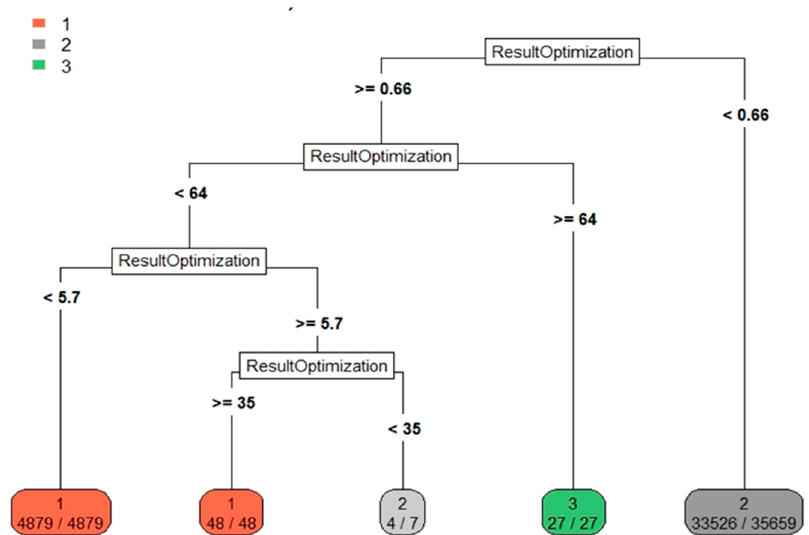
Figure 9. Decision tree. Results for the weekend scenario.